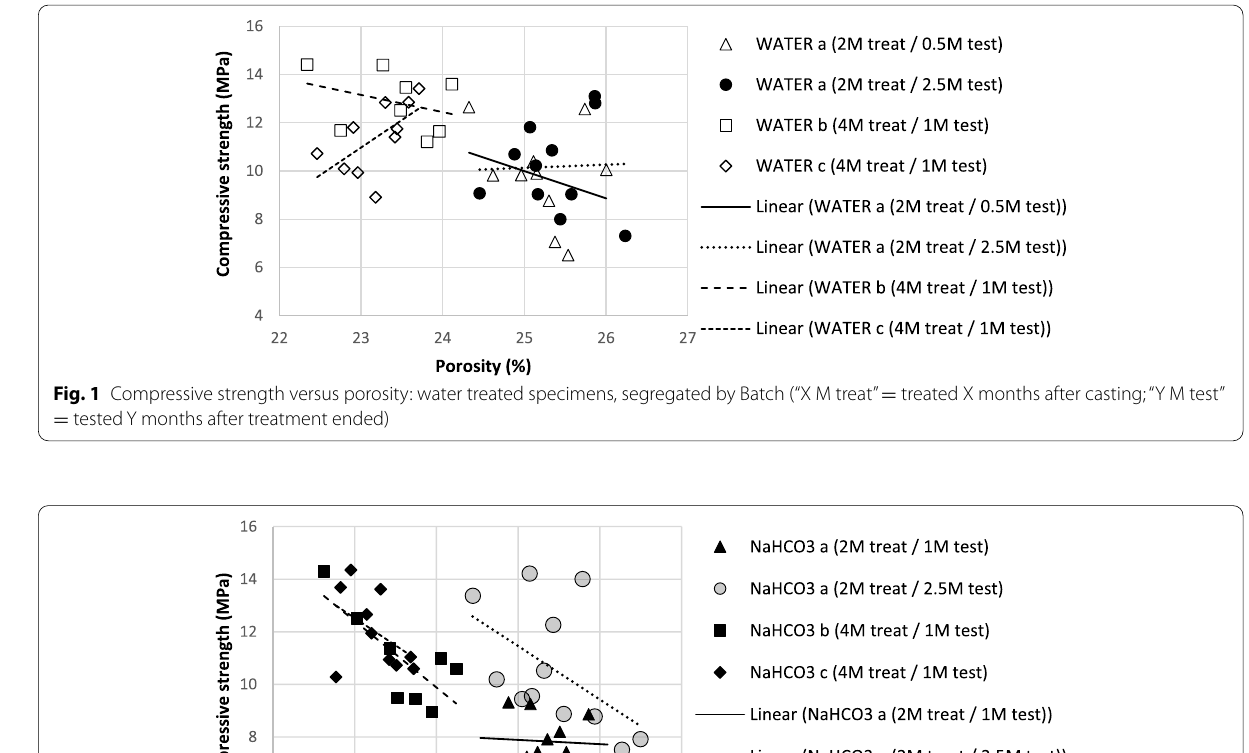
treated X months after casting; “Y M =